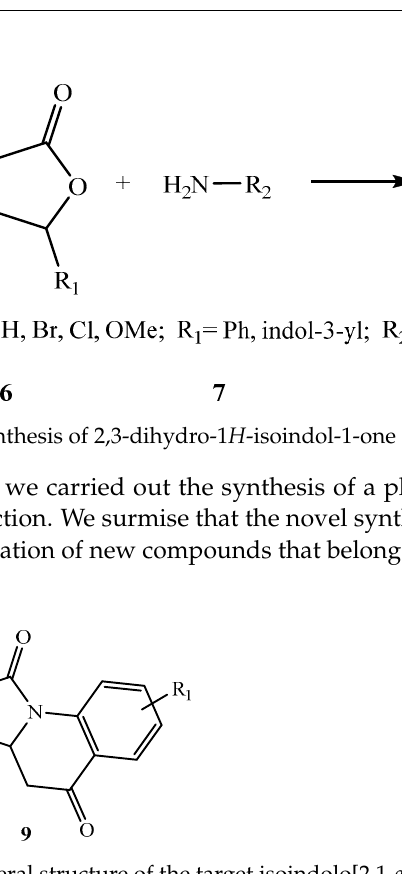
Figure 2. General structure of the target isoindolo[2,1- a ]quinoline derivatives.